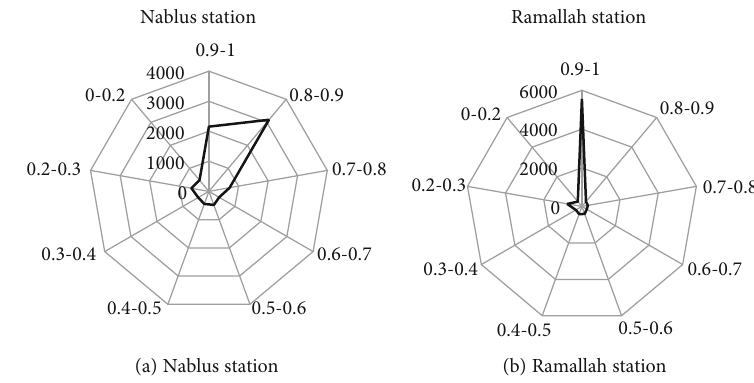
Figure 19: Usage of battery in Nablus and Ramallah stations for the third